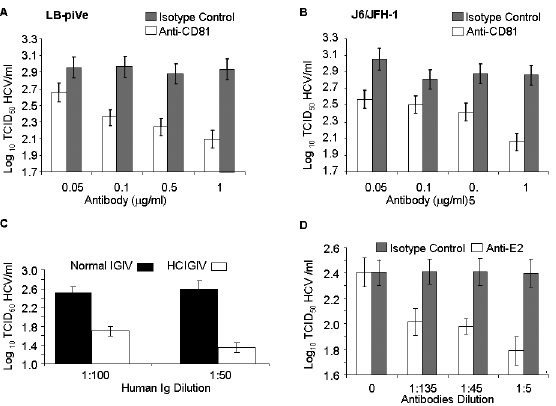
Figure 3. Virus neutralization by anti-CD81 and anti-HCV antibodies. (A) Huh7.5 cells were pre-incubated with anti-CD81 before infection with filter-clarified supernatants from LB-piVe cells or (B) J6/JFH-1-infected cells. M2, isotype-control antibody. J6/JFH-1 was titrated by an end-point dilution assay using indirect immunofluores- cence. Wells were scored positive if at least 1 positive cell was detected. (C) LB-piVe was neutralized by incubation with human anti-HCIGIV [35] or (D) anti-E2 monoclonal antibodies [36]. LBpiVe virus titers in A, C and D were determined by a CPE-based TCID 50 assay. HCV titers were calculated using the method of Reed and Muench [31]. Error bars, 6